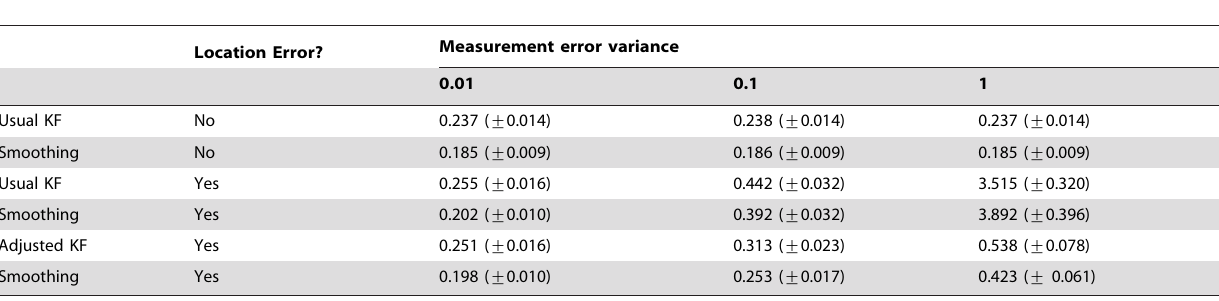
Table 1. Mean MSPE ( + standard deviation) of a 1000 simulated data sets with predictions from Kalman filtering and Kalman